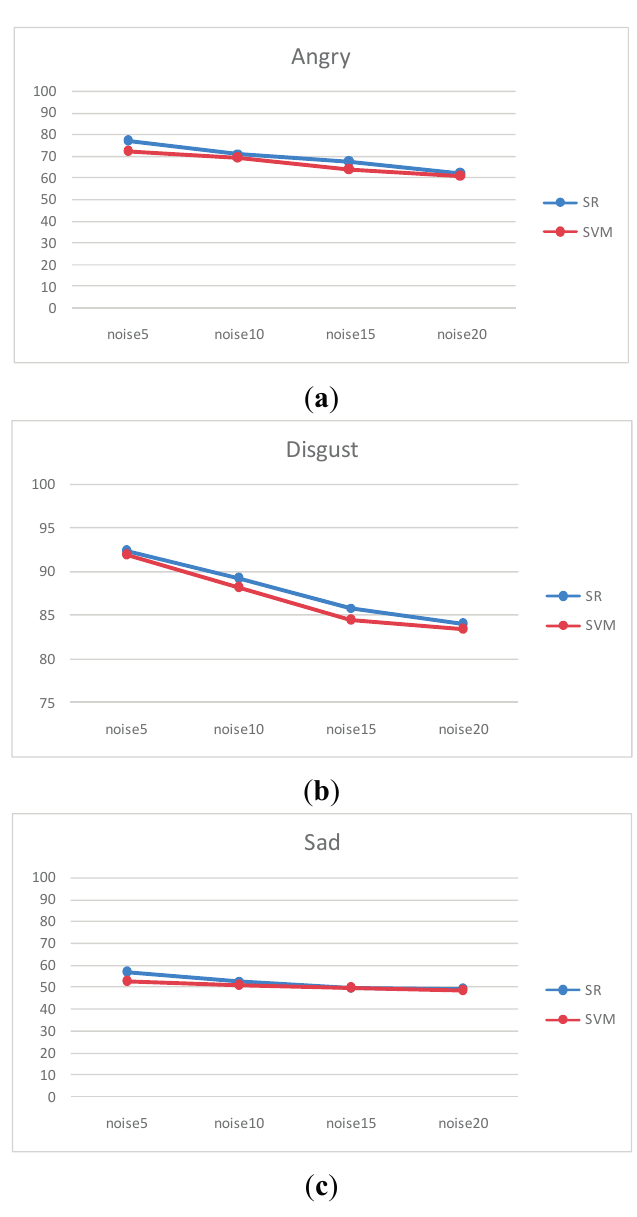
Figure 11. The comparison between SR and SVM against noise. ( a ) Angry; ( b ) Disgust; ( c )